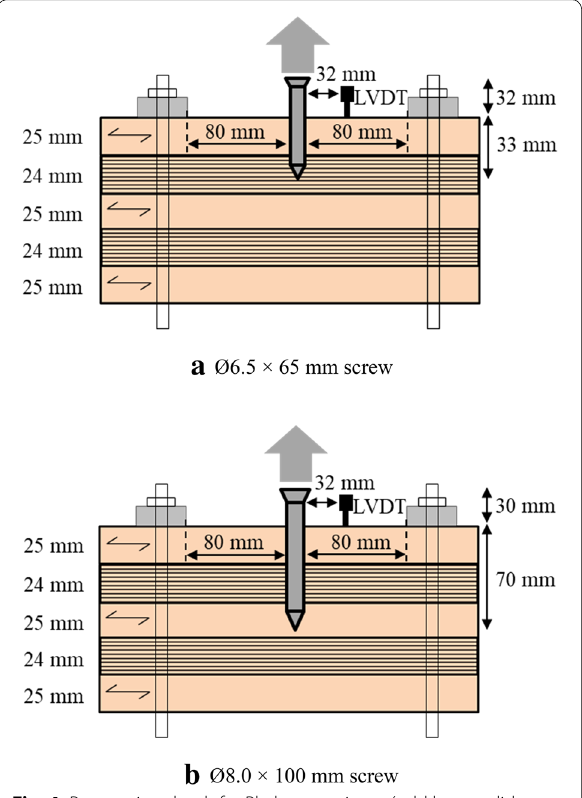
Fig. 4 Penetration depth for Ply‑lam specimen (odd layer: solid wood; even layer: